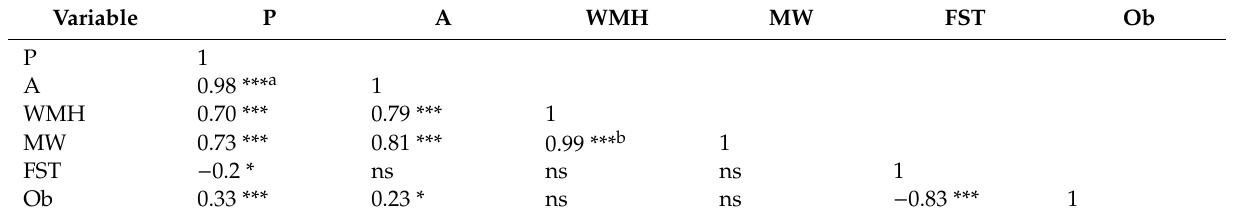
Table 3. Pearson’s correlation coe ffi cient among fruit morphology traits in the intra-specific tomato population NC 10204 in F 5:6 generation.